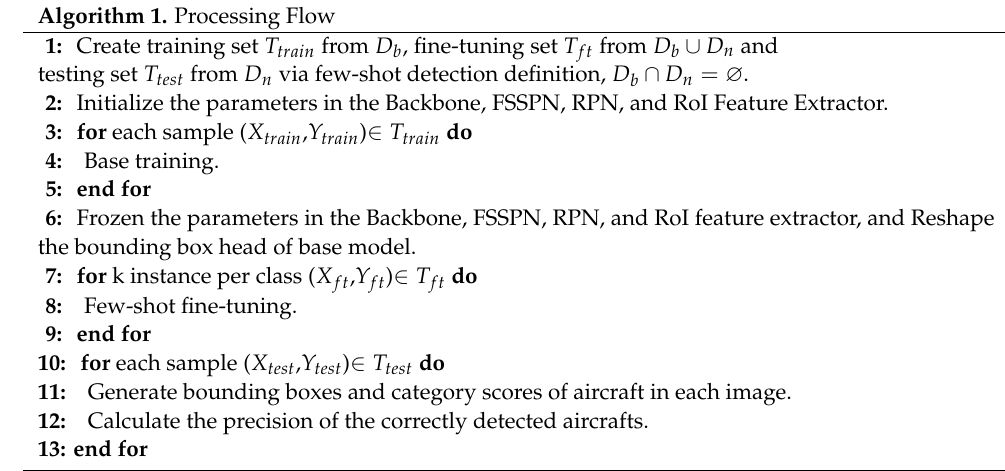
Algorithm 1. Processing Flow